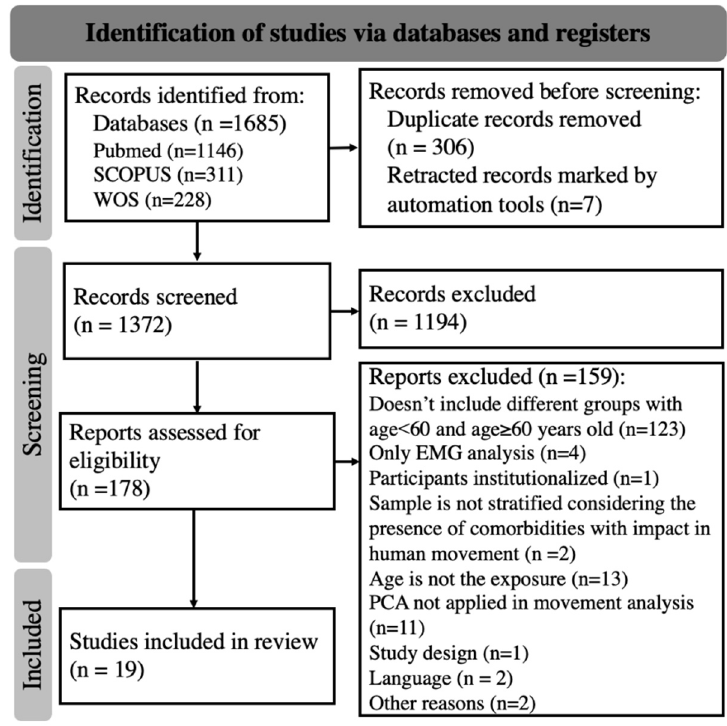
Figure 1. Systematic review PRISMA 2020 flow diagram.